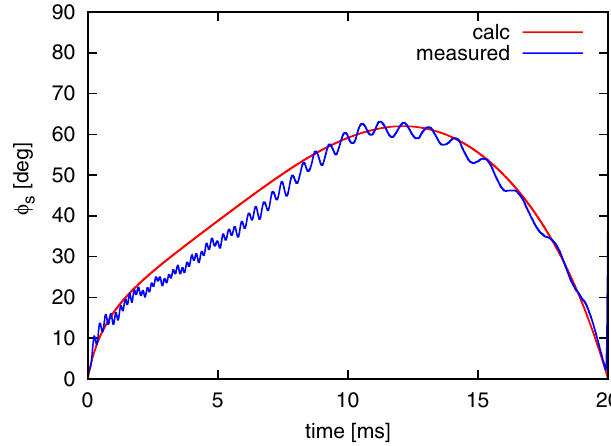
FIG. 18. (Color) Horizontal beam position data on (cid:1)R -BPM over the acceleration process (20 ms) before (dashed green curve) and after (solid red curve) the rf frequency tuning.